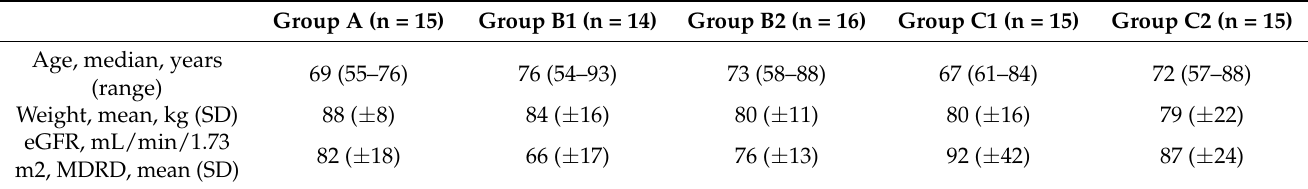
Table 1. Baseline